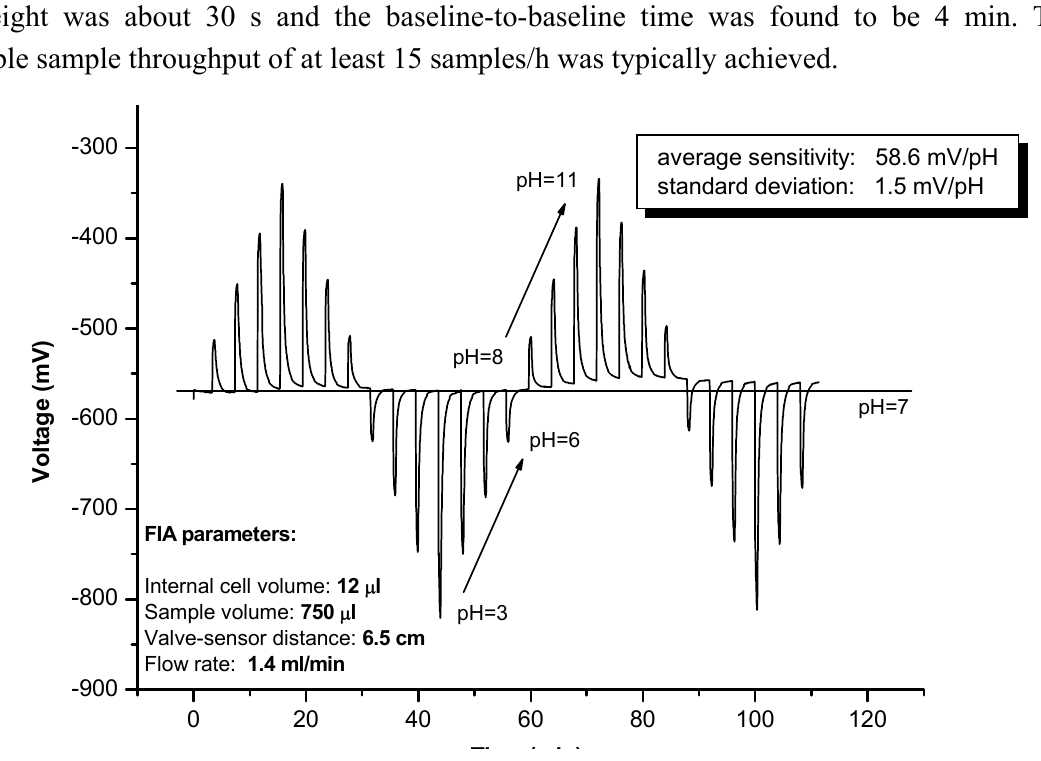
Figure 4. Typical FIA response of an EIS sensor under optimised FIA parameters. Penicillin measurement in FIA mode with EIS